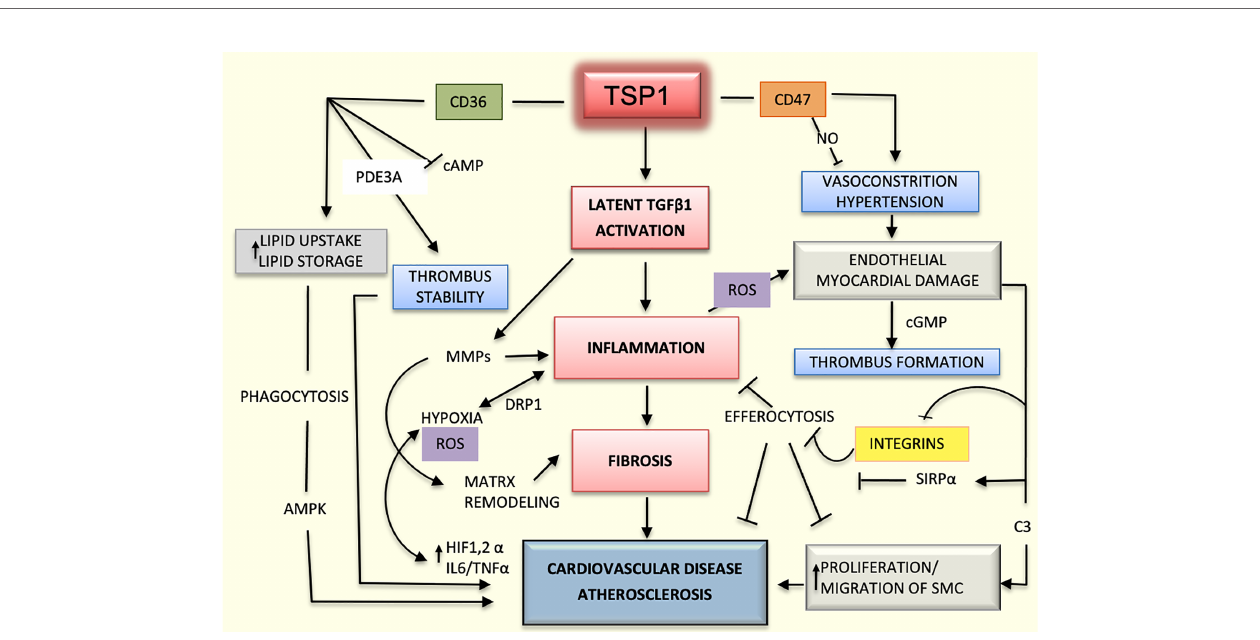
FIGURE 2 | Mechanisms mediated by TSP1 in cardiovascular diseases. The interaction of TSP1 with CD47 inhibits nitric-oxide (NO) levels, thereby decreasing vasodilation and compromising organ perfusion. Hypertension and endothelial injury can in turn, activate the coagulation system, promoting the initiation of thrombus. CD47 suppresses the activation of phagocytic and natural killer (NK) cells during atherogenesis, dampening the in fl ammatory response and efferocytosis by interacting with signal regulatory protein alpha (SIRP a ) and inhibiting integrins. TSP1 activates the latent transforming growth factor beta1 (TGF b 1) enhancing in fl ammation and fi brosis in the heart and vascular system. Additionally, this growth factor activates matrix metalloproteinases (MMPs), thereby contributing to matrix remodeling in atherosclerosis. In fl ammation-induced hypoxia activates hypoxia inducible factor-1 and 2 alpha (HIF1/2 a ) and increases the levels of interleukin 6 (IL6) and tumor necrosis factor alpha (TNF a ) promoting even more the in fl ammatory process and atherosclerosis. In fl ammation also enhances the production of reactive oxygen species (ROS) and cell damage. CD36, as a scavenger receptor B, promotes cellular uptake of lipoproteins and formation of foamy macrophages, which are part of the atherosclerotic plaque. Additionally, by interacting with TSP1, CD36 stabilizes the thrombus in the arterial wall and stimulates the proliferation and migration of smooth muscle cells (SMCs), contributing even further to the atherosclerotic